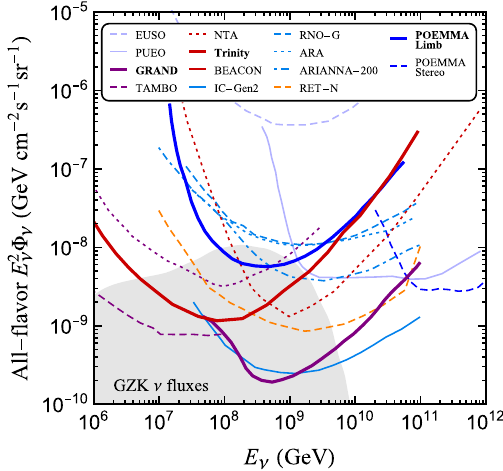
Fig. 18 Projected sensitivities of future neutrino telescopes to the all- flavor cosmogenic neutrino flux above PeV energies. Figure from Ref.